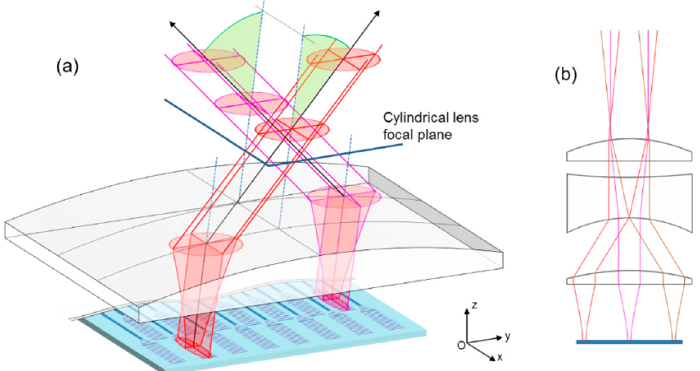
Figure 2. ( a ) Schematic of the use of a cylindrical lens to compensate exit mode ellipticity and obtain sub-degree divergence in both the horizontal ( x ) and vertical ( z ) directions; ( b ) Example of a three-element optical system implementation.